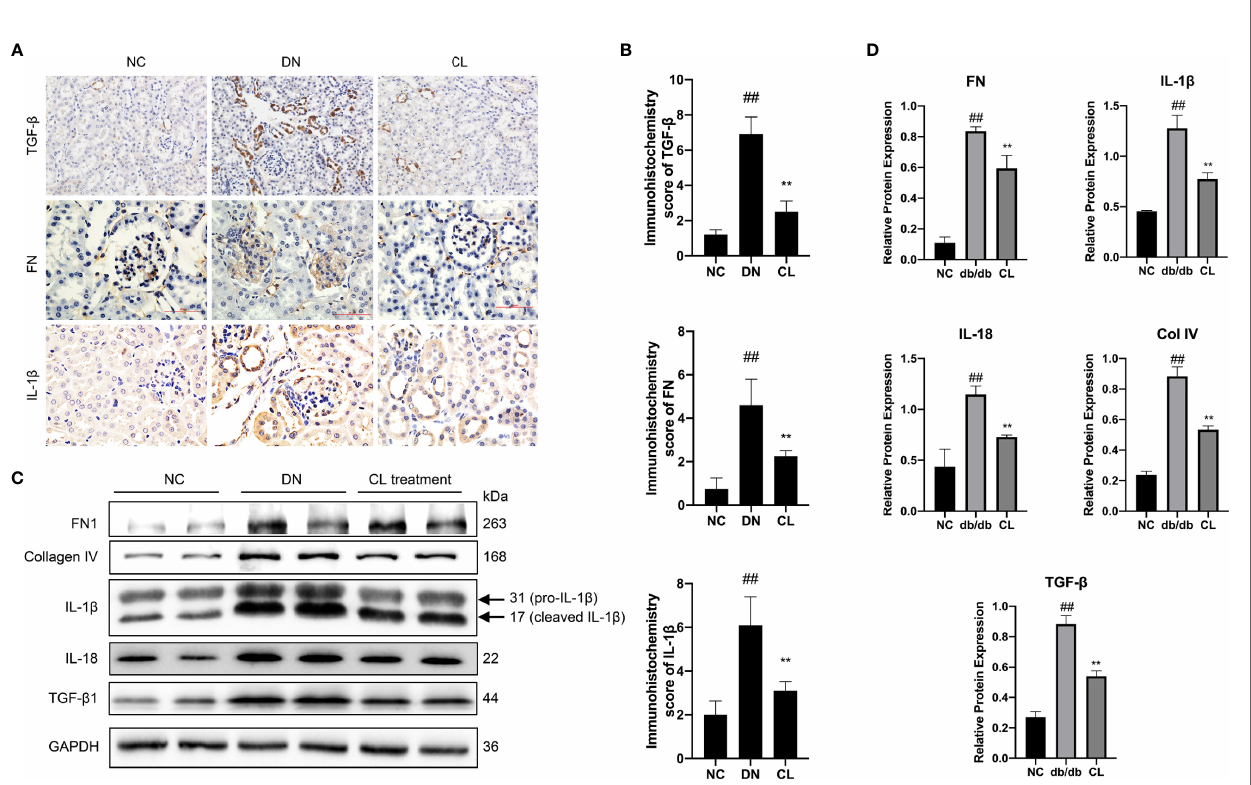
FIGURE 6 | Macrophage depletion reduces the level of in fl ammation and fi brosis in the kidneys of diabetic mice. (A, B) Immunohistochemistry and Immunohistochemistry score were used to evaluate the levels of the in fl ammation and fi brosis indicators IL-1 b , TGF- b , and FN in mouse kidney tissue. (C, D) Western blot and semiquantitative analyses of the levels of in fl ammation and fi brosis indicators in the kidney tissue of mice. NC, normal control group (db/m); DN, diabetic nephropathy group (db/db), CL treatment: db/db + clodronate liposome treatment. ## p < 0.01 vs. the normal group (db/m), **p < 0.01 vs. the DN group